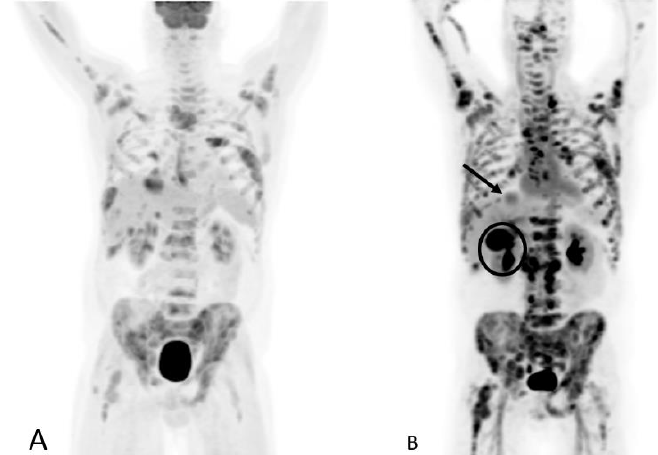
Figure 23. Sixty-one-year-old male with metastatic castration-resistant prostate cancer. FDG PET ( A ) shows widespread metastatic disease primarily involving the osseous structures and lymph nodes, the degree of FDG avidity suggesting high-grade malignancy. F18 DHT PET MIP ( B ) shows greater extent of metastatic disease, including improved visualization of lymph node metastases and a metastatic lesion at the liver dome (arrow). Note the hepatobiliary excretion of DHT with significant gallbladder activity (circle).